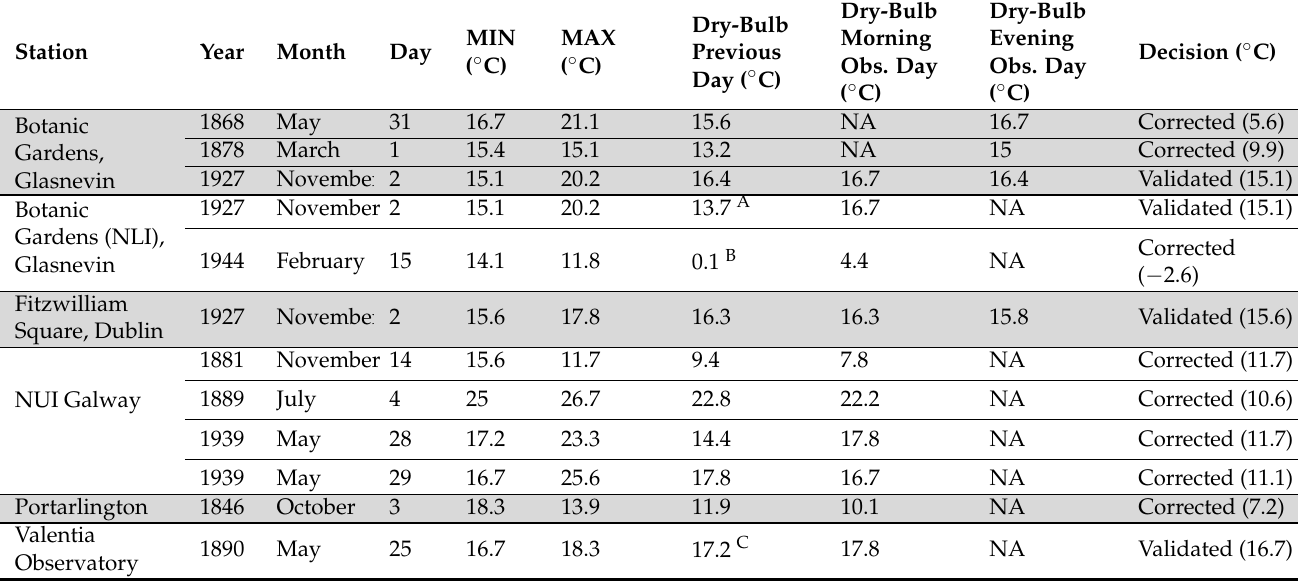
Table A2. Flagged upper daily MIN threshold exceedance (flag 2) and the dry-bulb thermometer registered on previous and observation